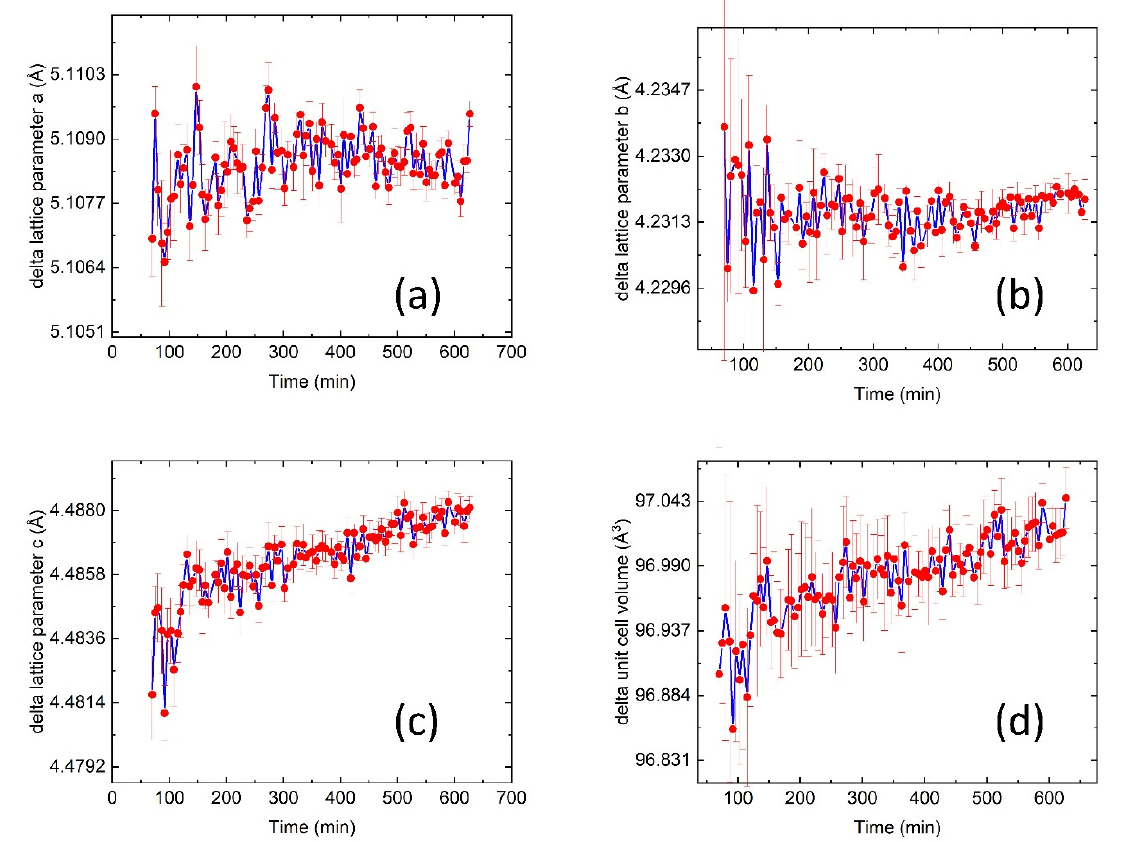
Figure 5. ( a – c ) Time dependence of the three lattice parameters of the δ phase precipitates, acquired from the in situ XRD measurements at 700 °C. ( d ) The volume of the unit cell of the δ phase precipitates.